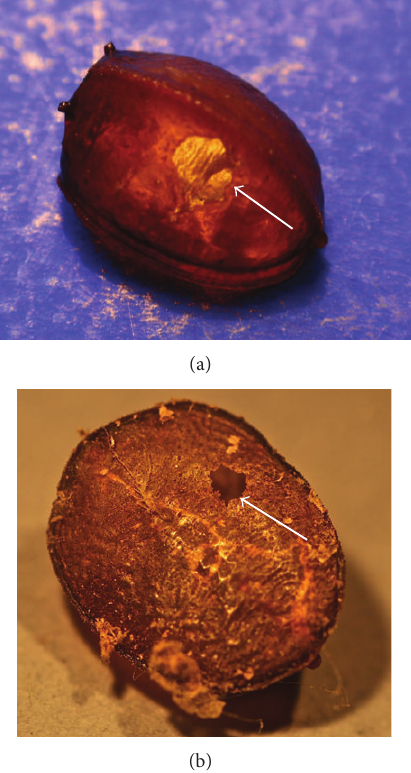
Figure 2: Parasitized puparia: (a) puparium (dorsal view) show- ing the emergence hole chewed by the eurytomids (arrow); (b) puparium (ventral view) showing the emergence hole chewed by eulophids (arrow). Photos: J.-P. Lachaud and G. P´erez-Lachaud.